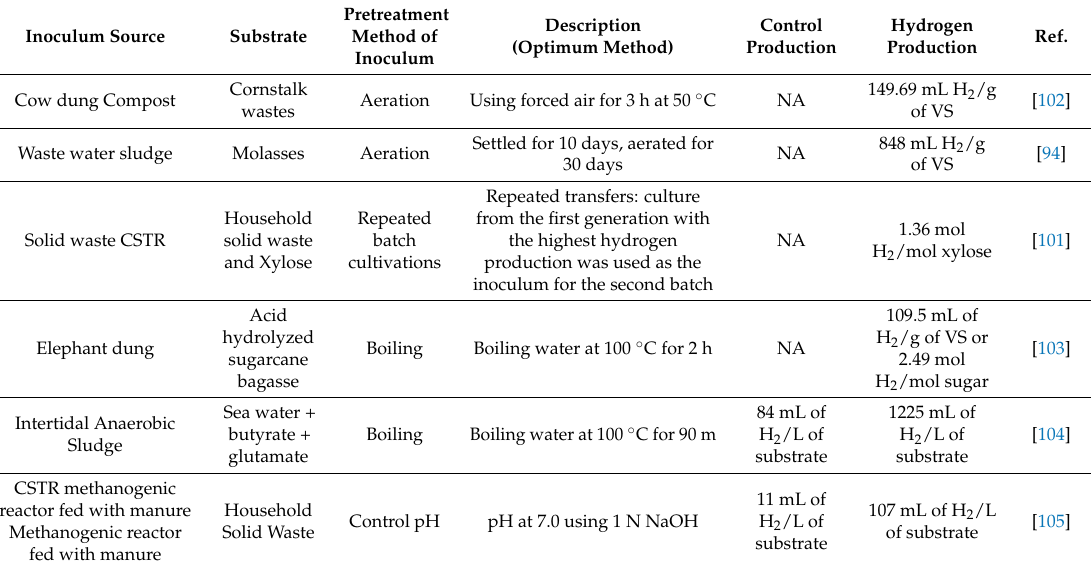
Table 4. Hydrogen yield by mixed culture using other